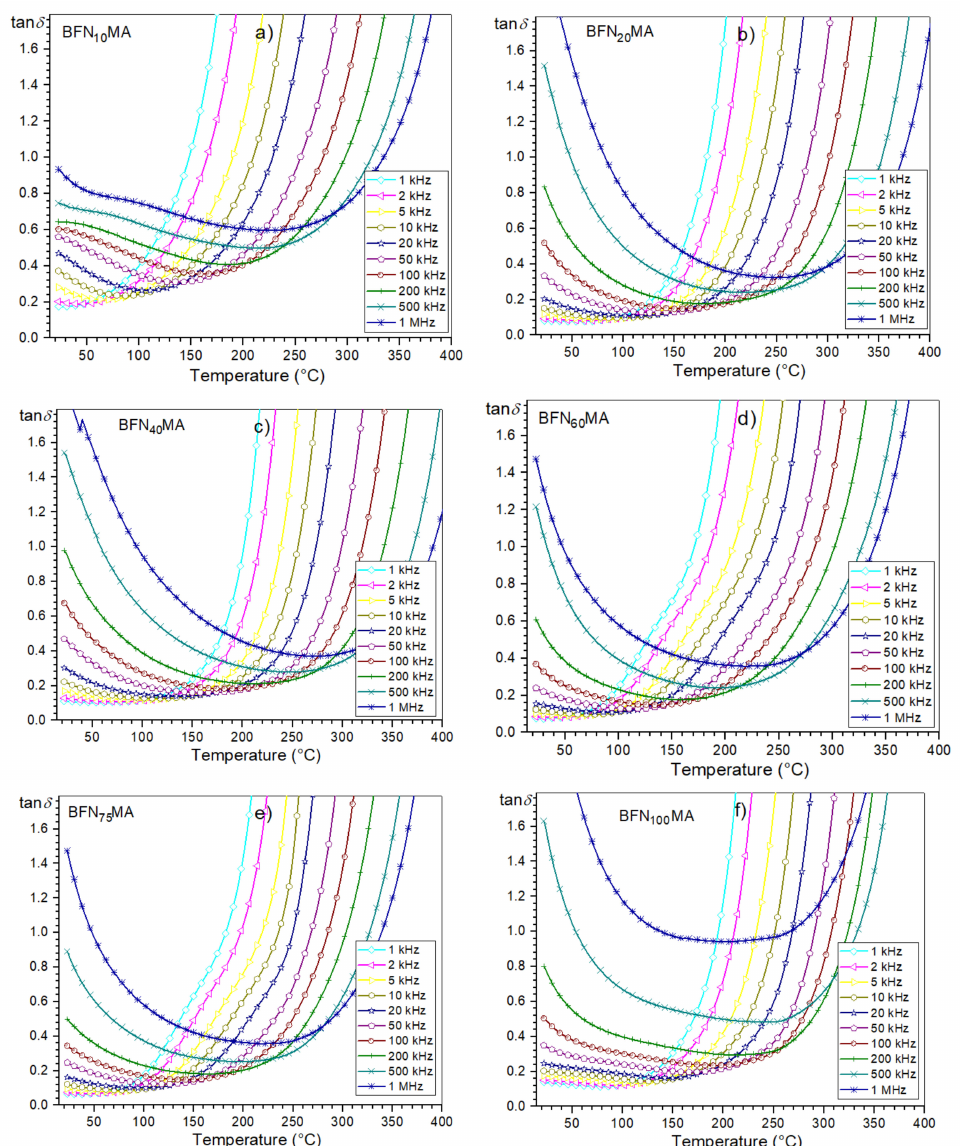
Figure 7. Temperature dependencies of dielectric loss for BFN x MA ceramic samples: BFN 10 MA ( a ),